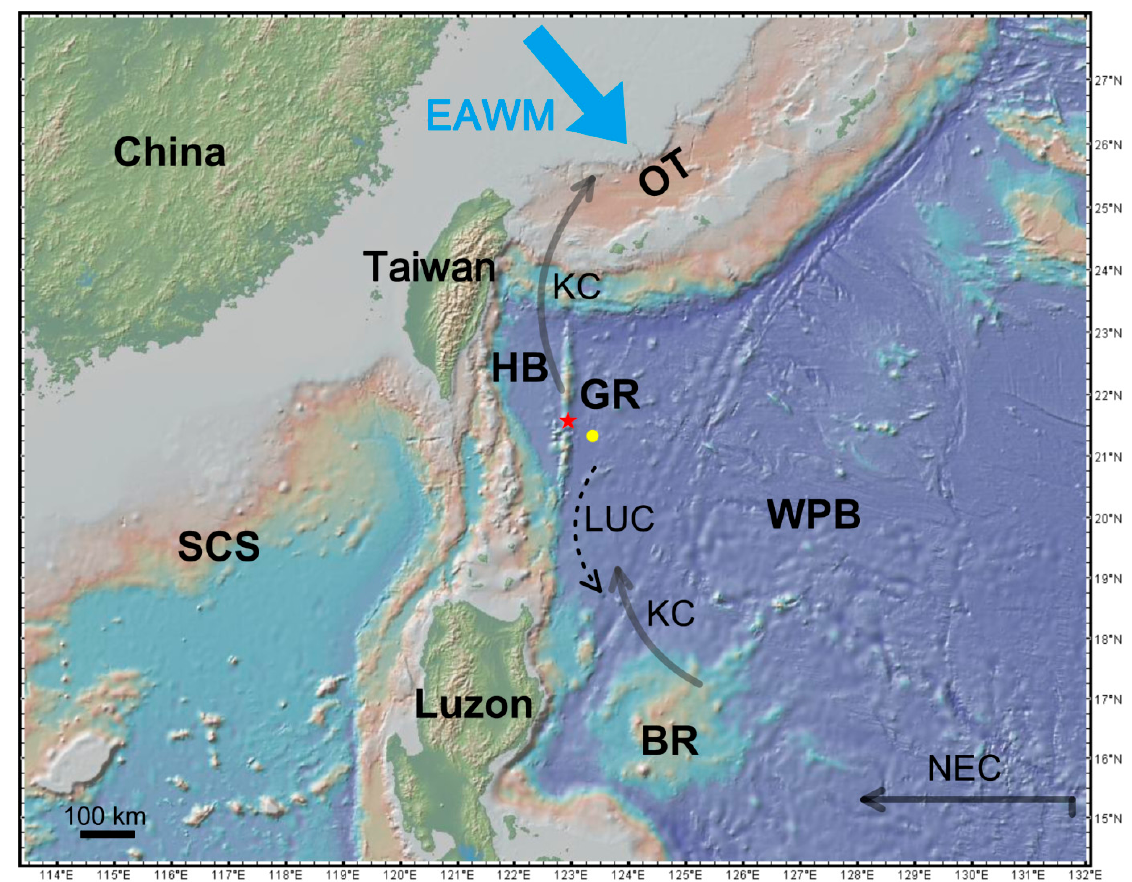
Figure 1. Location map of the sampling site (TVG12-4, indicated by red star) modified from Chen et al. (2018) [3]. The yellow circle depicts the sediment core location of stations PH-6 and St 6 (depth > 5500 m; [25]). The flow paths of the main currents are shown by the gray and dashed black arrows. NEC-North Equatorial Current, KC-Kuroshio Current, LUC-Luzon Undercurrent, SCS-South China Sea, BR-Benham Rise, WPB-West Philippine Basin, GR-Gagua Ridge, HB-Huatung Basin, OT- Okinawa Trough, and EAWM-East Asian winter monsoon. The bathymetric map is sourced from GeoMapApp (http://www.geomapapp.org).